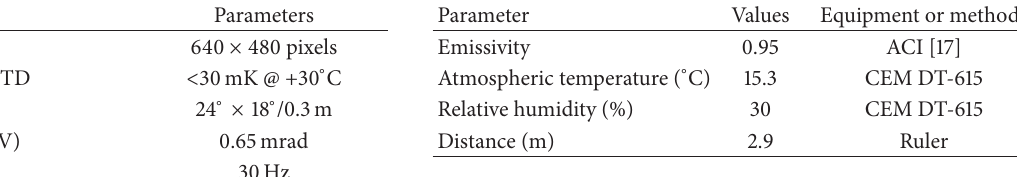
Table 4: Initial parameters of IR